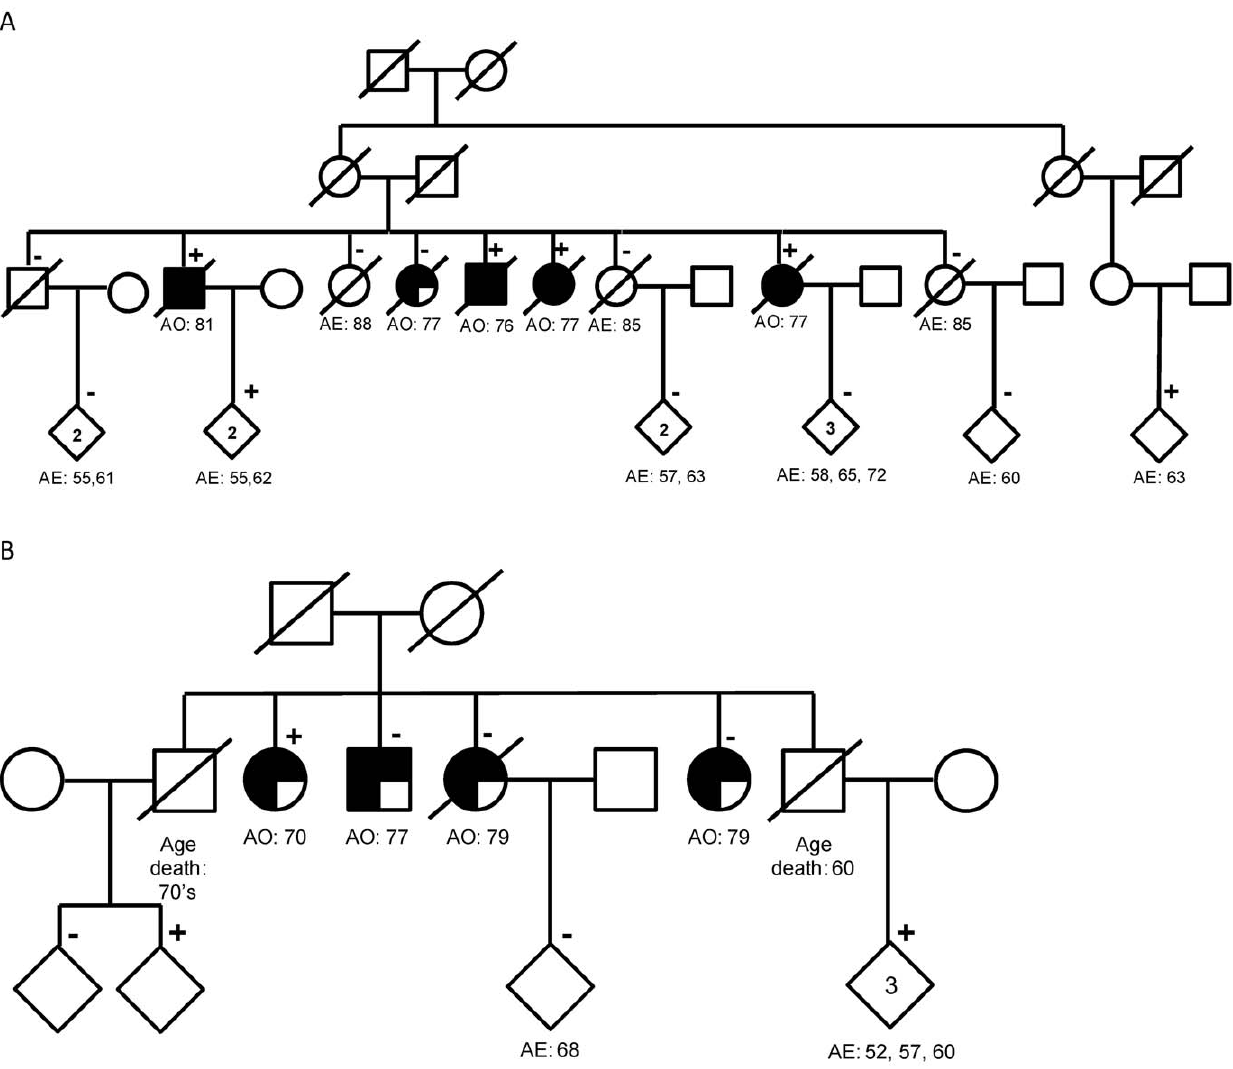
Figure 1. Pedigrees for some of the sequenced families illustrating the presence of phenocopies and low penetrance mutations or the presence of presymptomatic cases. A) Pedigree for a family with the PSEN1 A79V mutation. B) Pedigree for a family with the GRN R493X mutation. AO indicates the subject or family report of age of onset of symptoms. AE=the age of last evaluation. MCI: Mild cognitive impairment or questionable dementia by family report. + symbol indicates that the subject is positive for the indicated mutation. 2 symbol indicates that the subject is negative for the indicated mutation. A number inside of a diamond indicates the number of subjects with the same status. Fully shaded circles or squares indicate confirmed AD by autopsy. Three/fourths shaded symbol indicates probable AD diagnosed using NINCDS-ADRDA criteria. One/fourth shaded symbol indicates that the family reports this individual has AD.